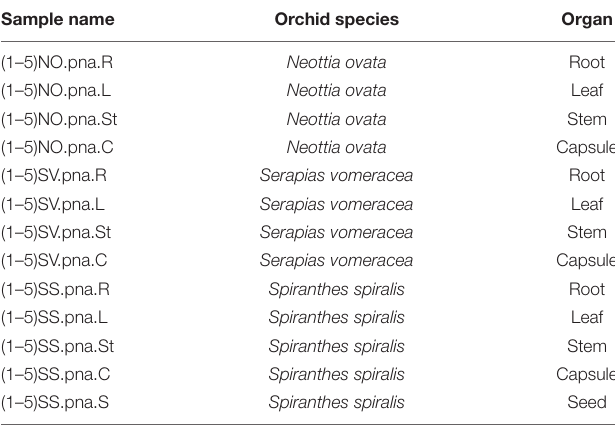
TABLE 1 | Samples of the orchid species/organs investigated in this